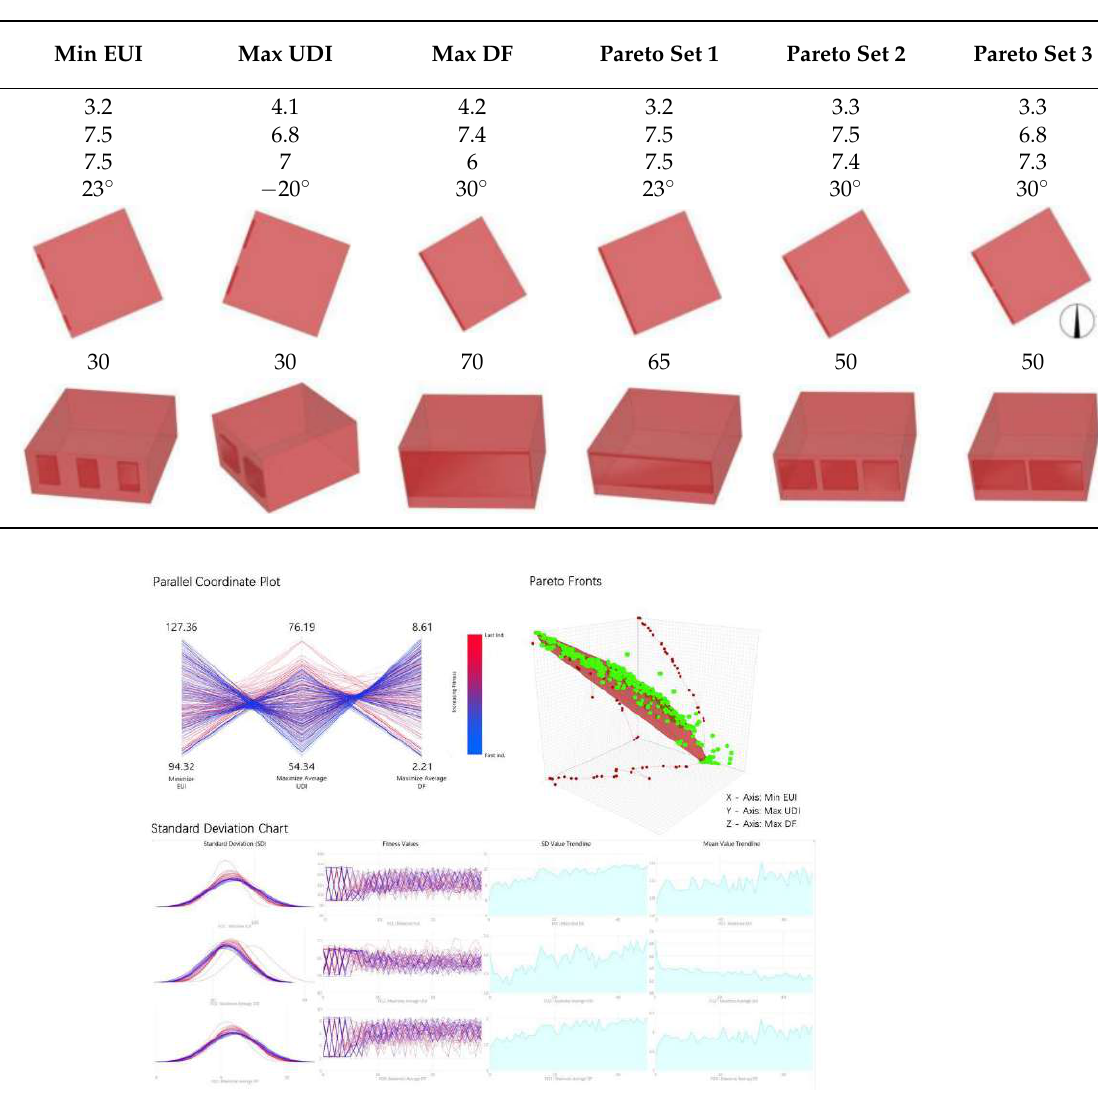
Figure 7. Parallel coordinate plot, Pareto Fronts output, standard deviation, and trendline of each index in small, west-oriented classrooms.